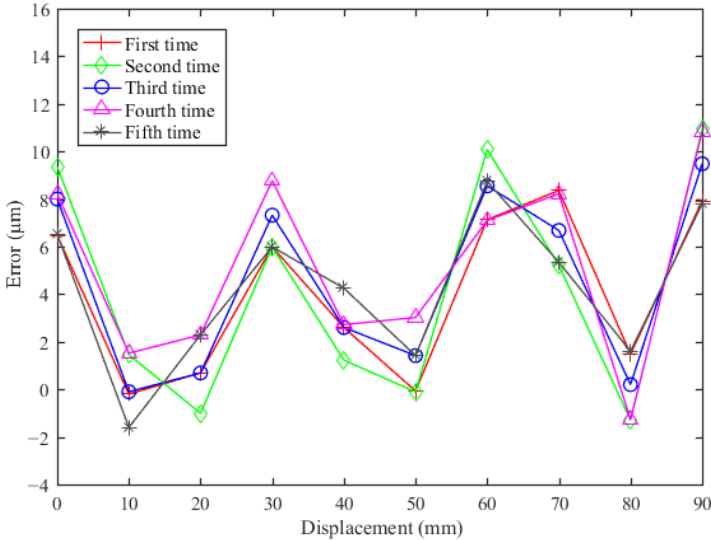
Figure 13. Sensor repeatability measurement result.